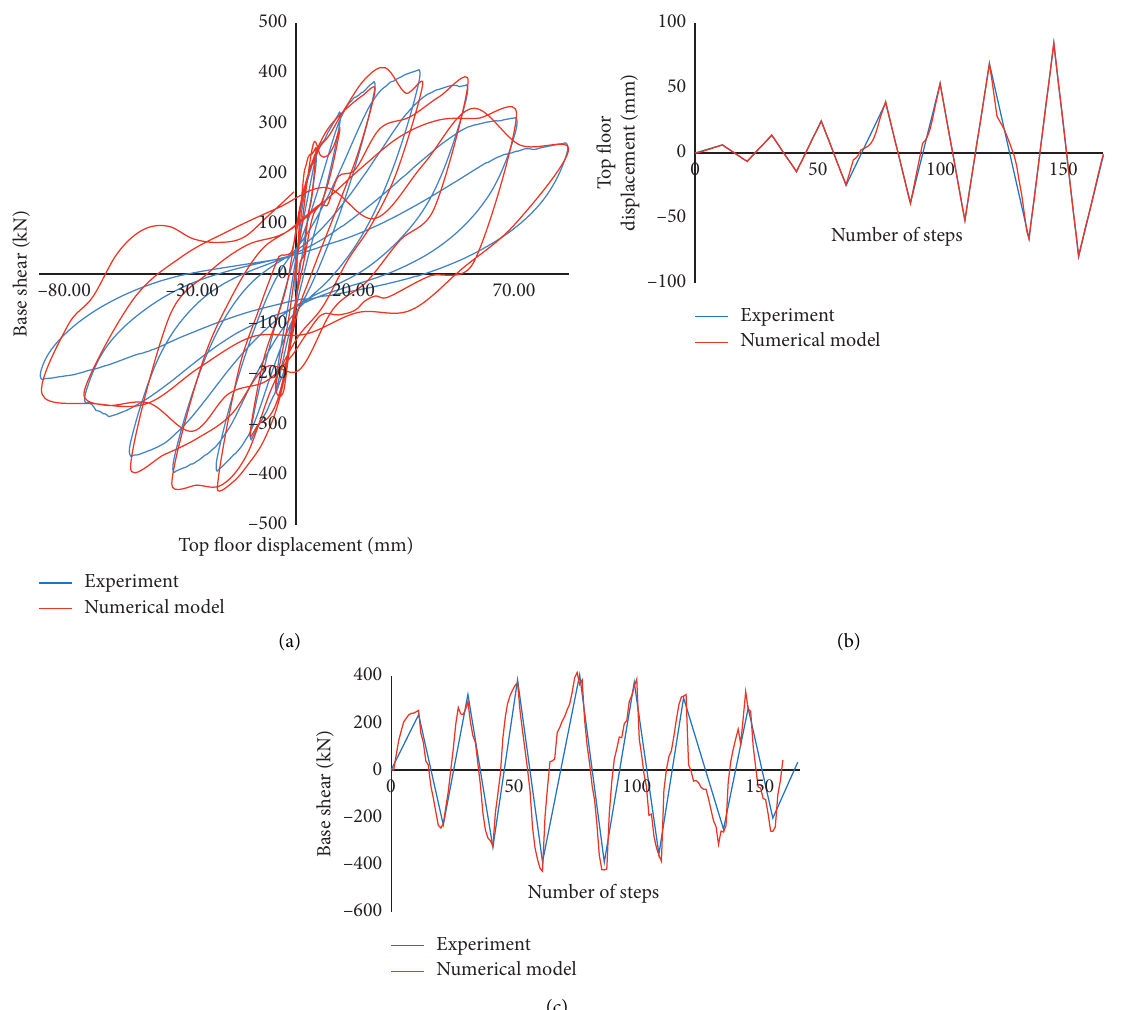
Figure 7: Comparison between experimental and numerical model results in terms of (a) base shear and top floor displacement hysteric curves, (b) base shear in relation to the load step, and (c) and top floor displacement in relation to the load